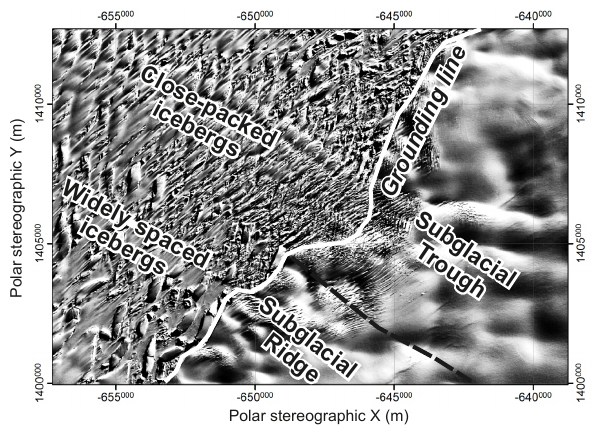
Figure 6. Landsat image of the region around the grounding line (location Fig. 2). Intense crevassing occurs 3–4km upstream of the grounding line. The ice retains no structural integrity on crossing the grounding line; the ice shelf is composed entirely of separated blocks held together by sea ice. Where the ice flows from a sub- glacial trough, the blocks remain closely packed with narrow chan- nels of sea ice between them, but where the ice flows off a subglacial ridge, the blocks are widely spaced with extensive areas of sea ice